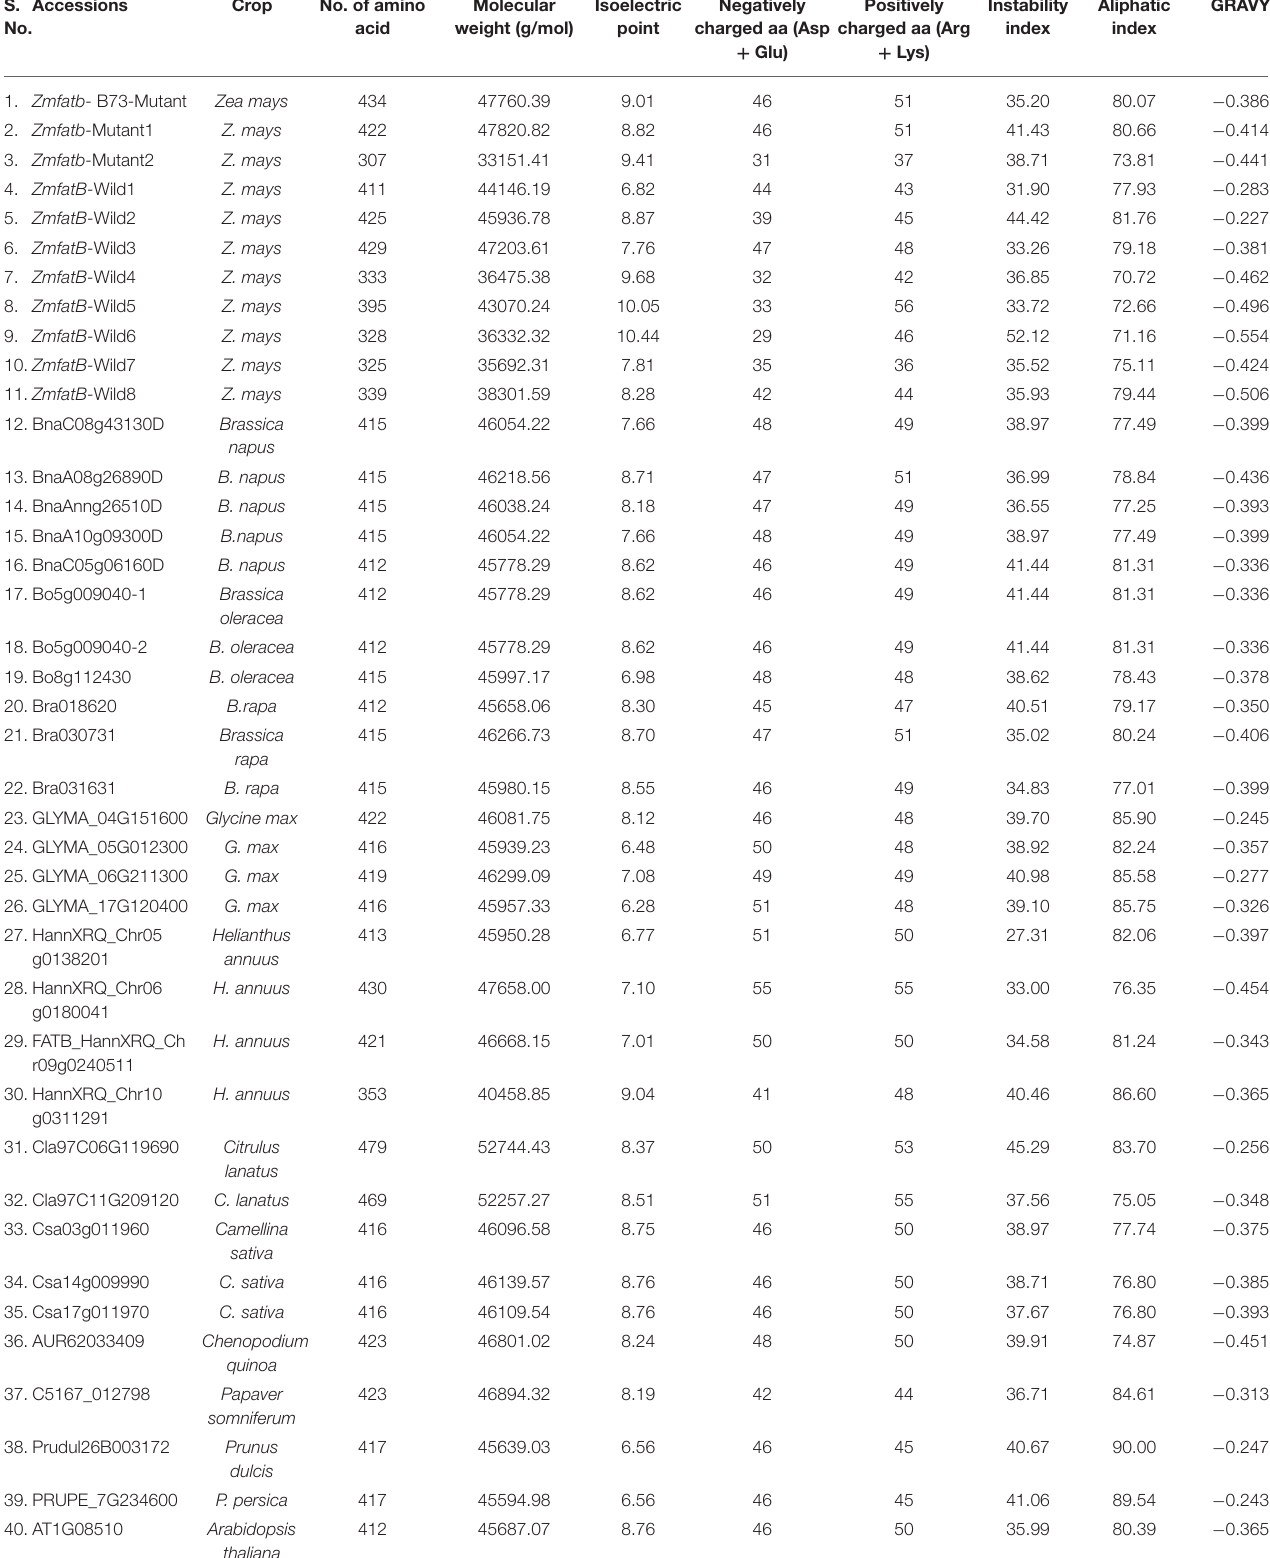
TABLE 4 | Physico-chemical properties of ZmFATB protein in maize and its selected orthologue accessions. S.